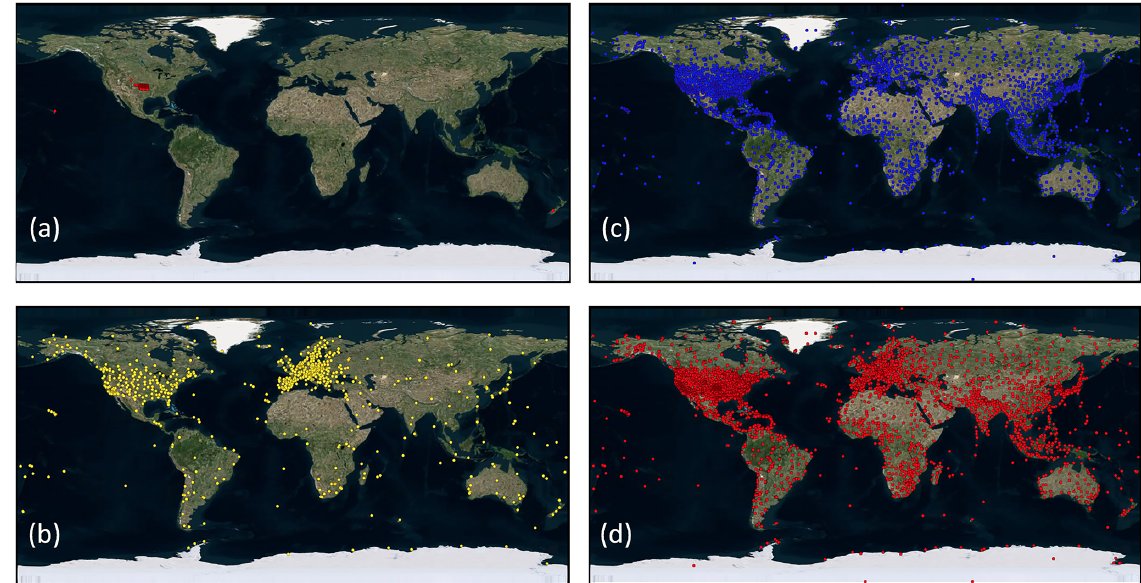
Figure 6. Classification based upon primarily uncertainty MSMM category scores of the existing networks at the global scale providing in-situ water vapour measurement. Panel (a) shows water vapour networks classified as comprehensive, (b) shows the networks classified as baseline, (c) shows the networks classified as reference, and (d) finally shows all the networks measuring water vapour at once. In this realisation, networks measuring the vertical profile, the full column content or at the surface have not been differentiated from one another. This figure highlights that most of the networks are classified as baseline in their capability to report the measurement uncertainty and that most of the water vapour measurements are collected in the Northern Hemisphere. By construction reference networks meet both baseline and comprehensive network requirements and similarly baseline measurements fulfil comprehensive network requirements.